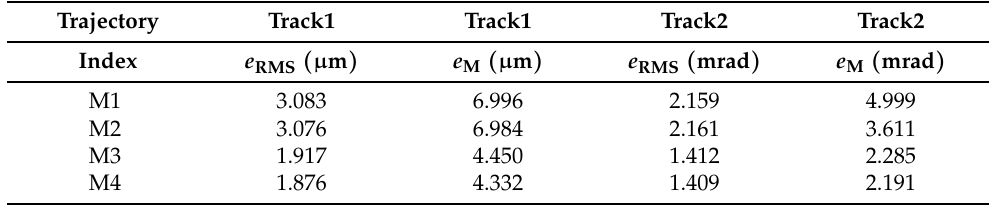
Table 1. Tracking performance of the MLRT without external